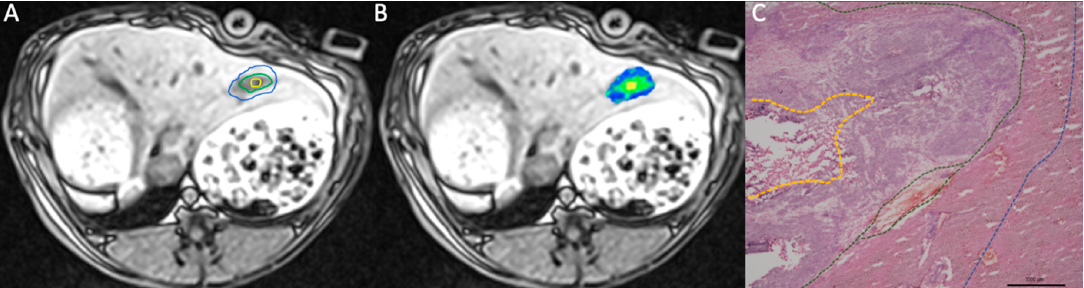
Figure 2. Schematic illustration of manually segmented tumor regions. ( A ) Axial T1-weighted images were used for delineation of the tumor center (yellow), margin (green), and the peritumoral region (blue). ( B ) Corresponding native MOLLI color-coded map depicting regional T1 times. ( C ) Corresponding segmentation in the histopathological H&E-stained sections.